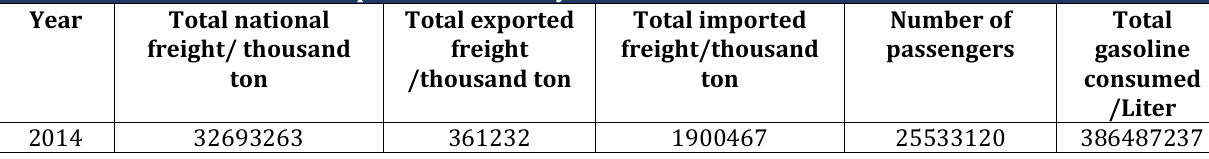
Table 3: Facts on Iran rail transportation